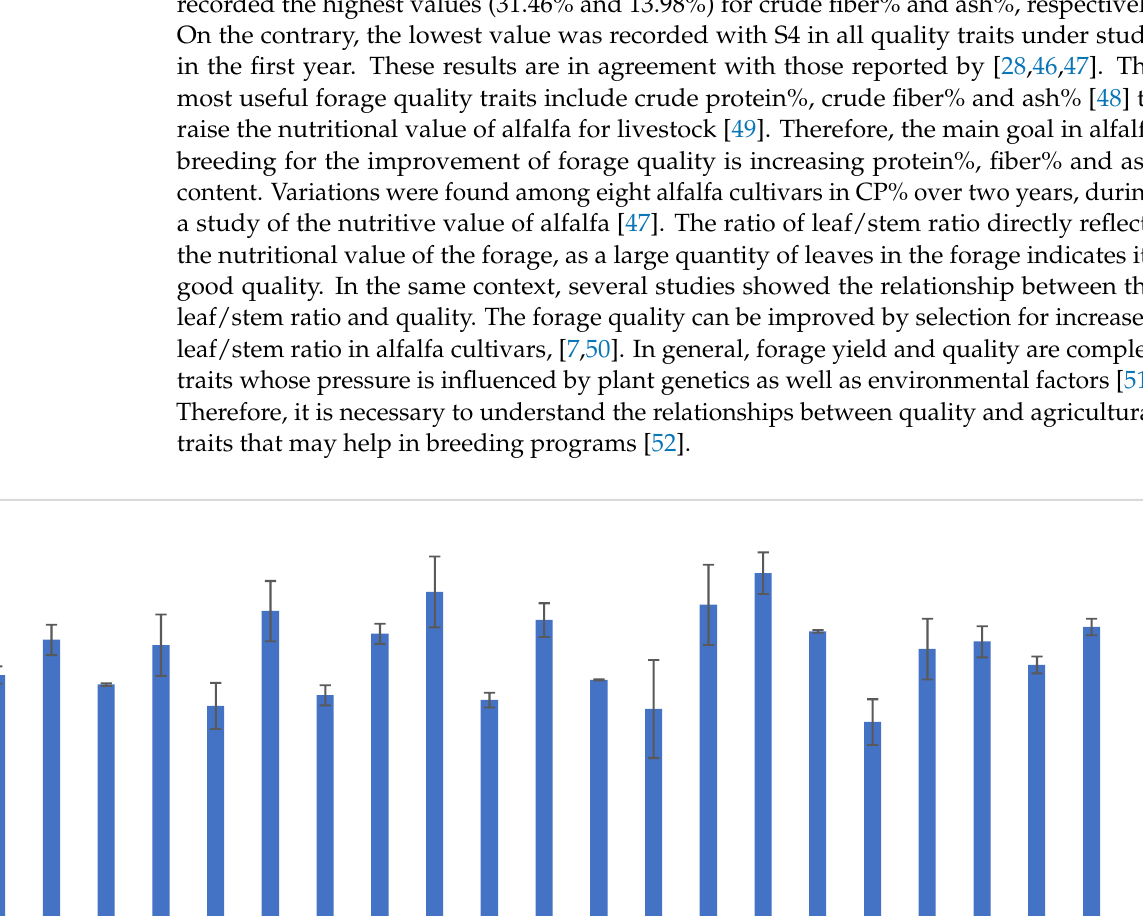
Figure 7. Mean performance of crude fiber % of twenty-one alfalfa genotypes in the first year. Bar represents the standard deviation.